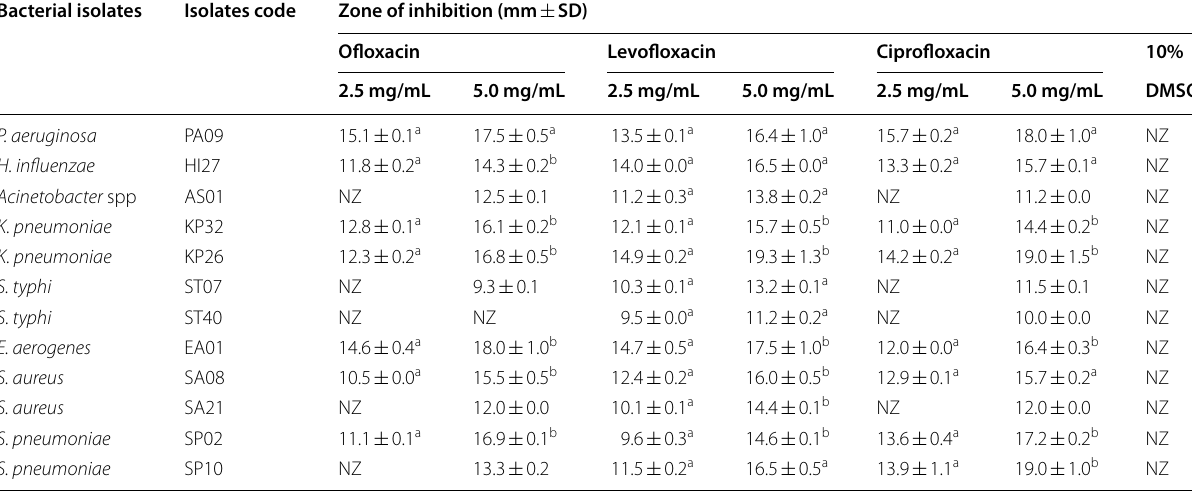
Each value represents the mean of three replicates and standard deviation. Mean within the column followed by the different superscript letters are significant as determined by Duncan’s multiple range test ( P < 0.05) mm Means, SD Standard deviation, NZ No inhibitory zone, DMSO Dimethyl sulphoxide Table 3 Minimum inhibitory and minimum bacteriocidal concentrations of fluoroquinolone antibiotics against etiology of bacteremia in HIV-infected patients Bacterial